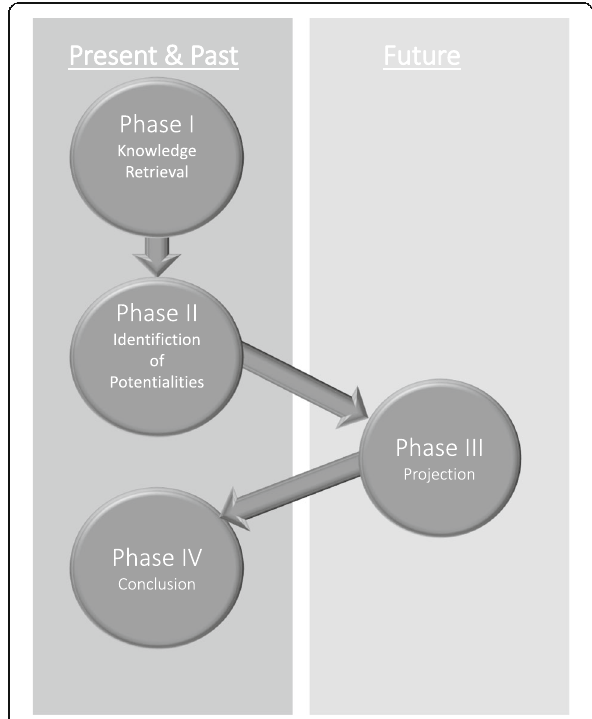
Fig. 2 Alternative view on the foresight